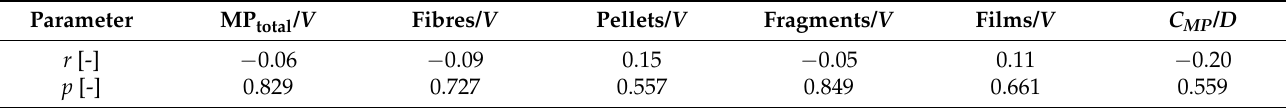
Table 2. Correlation analyses with Pearson’s t -test for filtered flow volume V [L] with the total MP number (MP total ) and the number of different shapes as well as the MP concentration C MP [MP particles/L] in contrast to the distance D from sampling points to the river’s mouth.